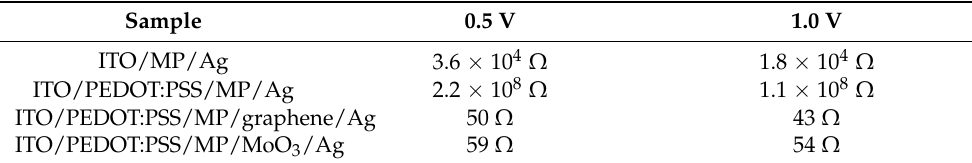
Table 2. Surface resistance of devices.